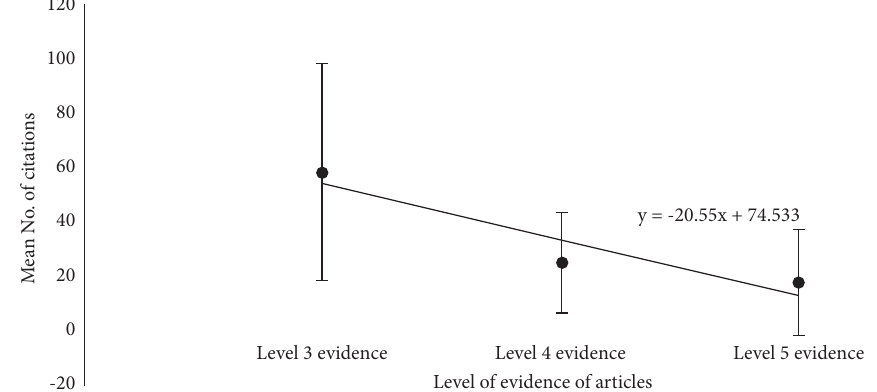
Figure 3: The mean ± SD number of citations per article plotted against the level of EBM. Articles with a higher level of EBM contained significantly more citations (rho � 2.44, p < 0 . 0005).